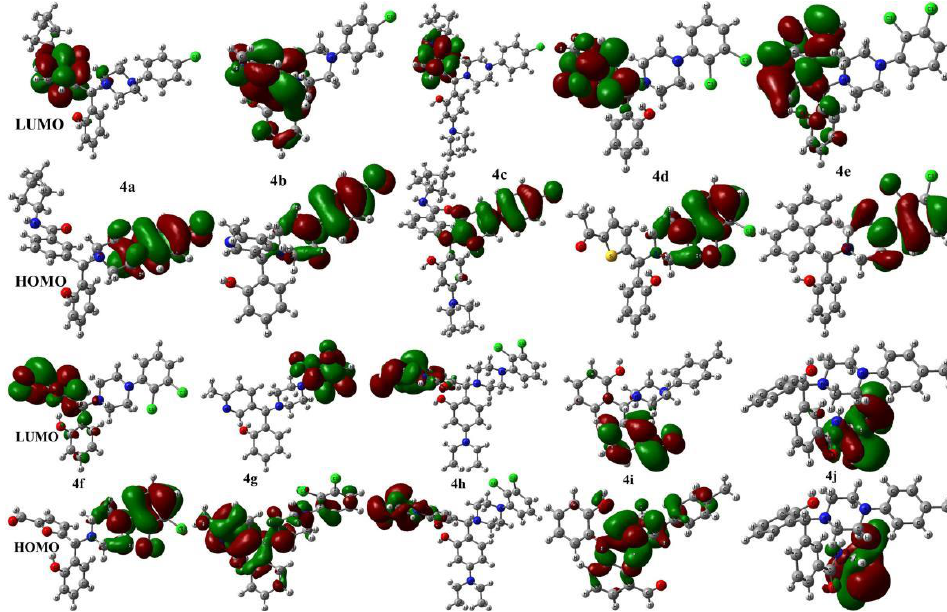
Figure 3. Computed molecular orbital plots for synthesized molecules 4a-4j with the counter value of 0.02 Å −3 . Table 3. Computed E HOMO , E LUMO , HOMO-LUMO gap ( ∆ ), chemical hardness ( η ), electronegativ- ity ( χ ), and electrophilicity index ( ω ) in eV for all the synthesized